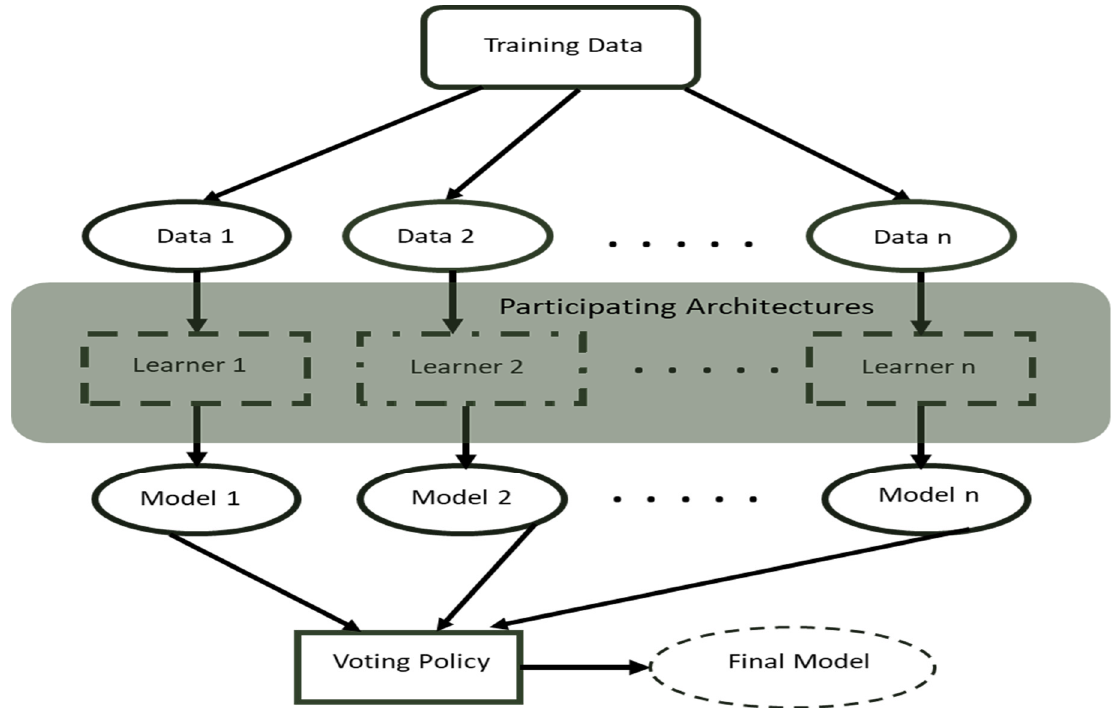
Figure 1. A cross-section of the ensemble model workflow with voting policy.